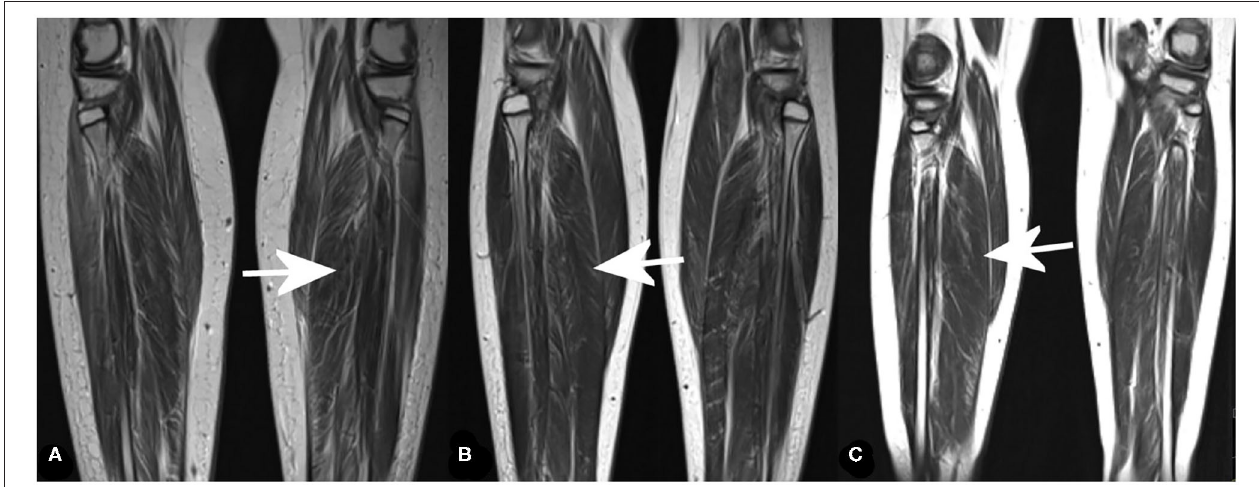
FIGURE 2 | MRI of distal muscles groups of the lower extremities (coronal T2-weighted images) showing fatty infiltration in the most affected muscle [soleus muscle (arrows)] in Patient 1 (A) , Patient 2 (B) , and Patient 3 (C) .